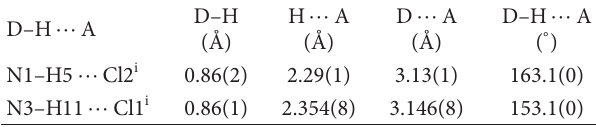
T 4: Hydrogen bond lengths (Å) and bond angles (